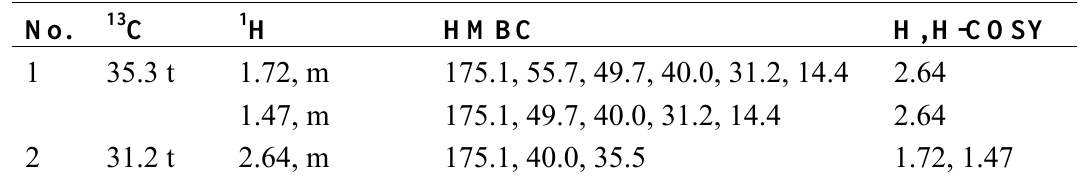
Table 1. 13 C-NMR (150 MHz), 1 H-NMR (600 MHz) data, HMBC and H, H-COSY correlations of Compound 4 (CDCl 3